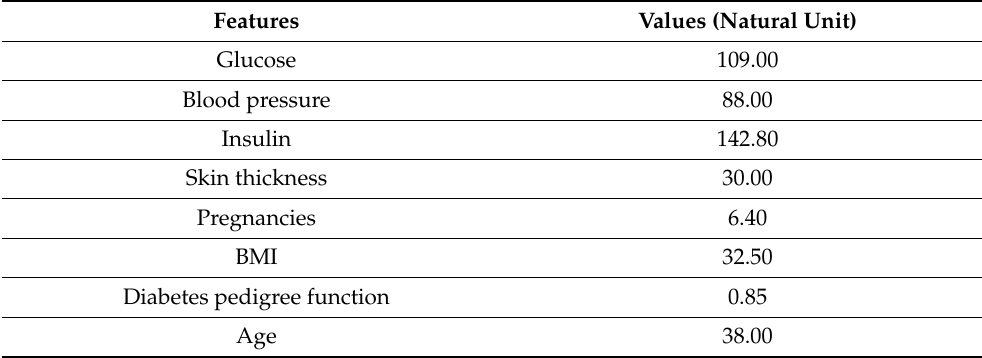
Table 7. Values (Natural unit) of every feature of a selected test sample corresponding to Figure